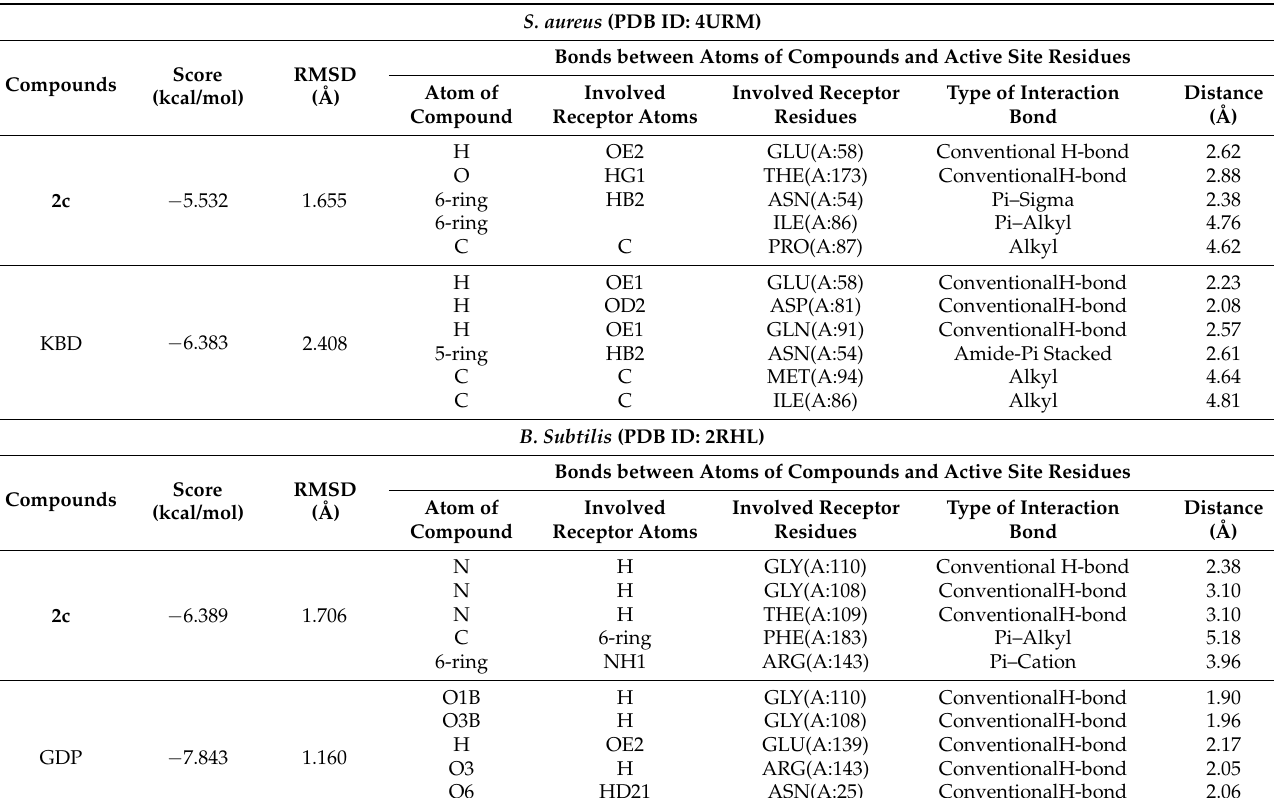
Table 6. S-score (Energy), RMSD, and interactions between compound 2c and the active site residues of S. aureus (PDB ID: 4URM) and B. subtilis (PDB ID: 2RHL)